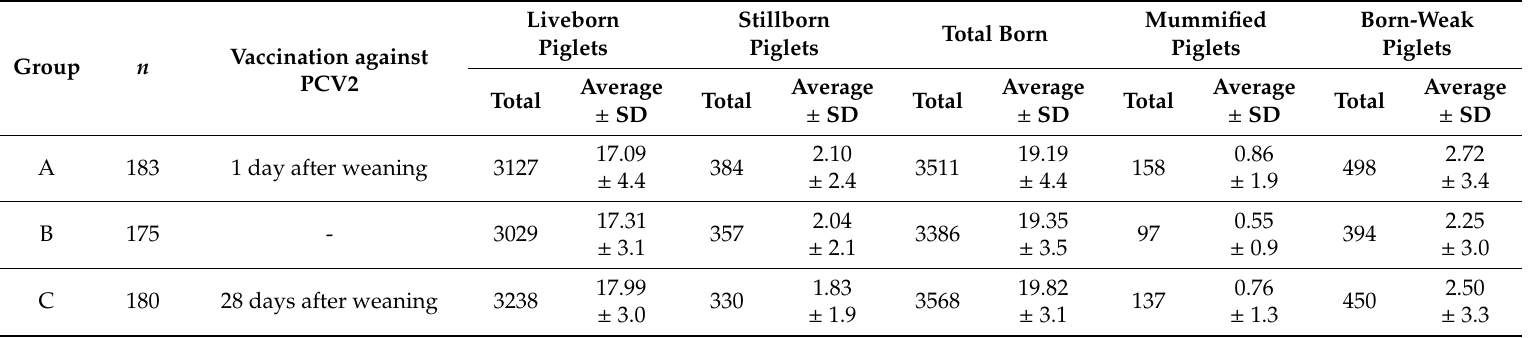
Table 1. Reproduction parameters in all (2nd–7th parity) sows observed during the trial. n : number of sows in each group, SD: standard deviation.